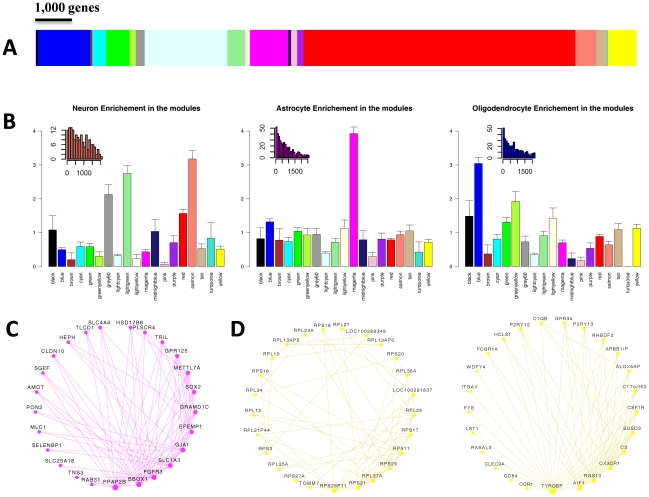
Weighted gene co-expression network analysis (WGCNA) of human brain transcriptomes.(A) Color map showing the relative sizes of the different modules in the WGCNA analysis. Colors correspond to arbitrary names given to each module. (B) Enrichment for genes up-regulated in Neurons (left), Astrocytes (center) and Oligodendrocytes (right). For each module, the relative risk (RR) for harboring cell-type specific genes is plotted. Insets show the distribution of the rank of enriched genes located in modules with the highest cell-type specific RR. The distribution is shown for the Salmon, Magenta and Blue module for genes enriched in neurons, astrocytes, and oligodendrocytes (respectively). (C) Top connected genes in the Magenta module. Nodes are ordered and sized according to their degree. (D) Top connected genes in the Yellow module, revealing two distinct groups of genes. One group (left circle) includes genes involved in protein translation, and the other (right circle) includes Microglia specific genes.